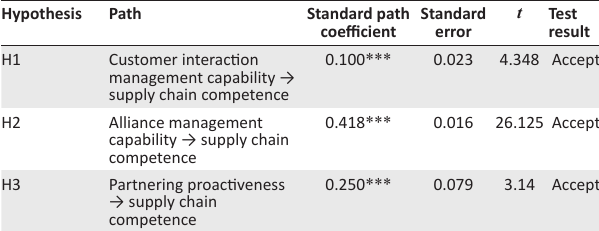
TABLE 4: Result of the hypotheses testing. Hypothesis